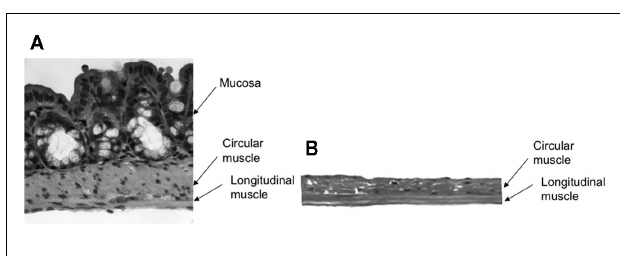
FIGURE 3 | Hematoxylin and Eosin (H and E) stain of control (undissected) (A) colon, and dissected colon (B), with mucosa and submucosal ganglia